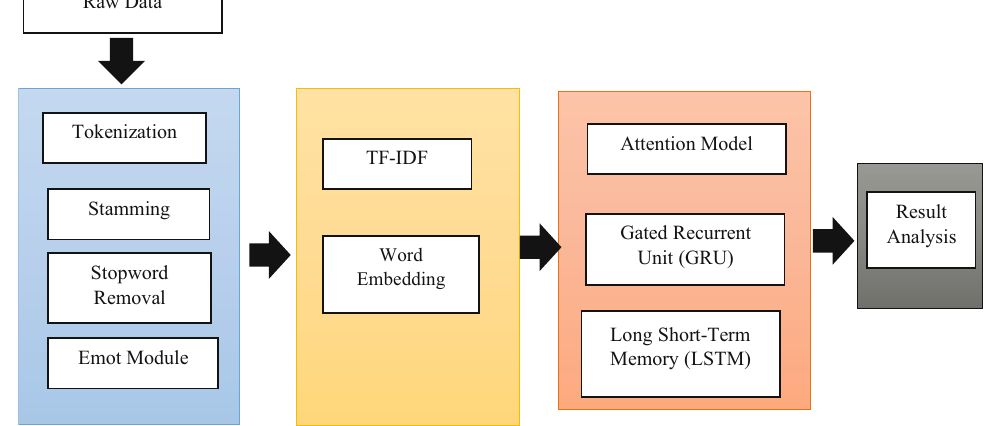
Figure 1: Infrastructure of our proposed